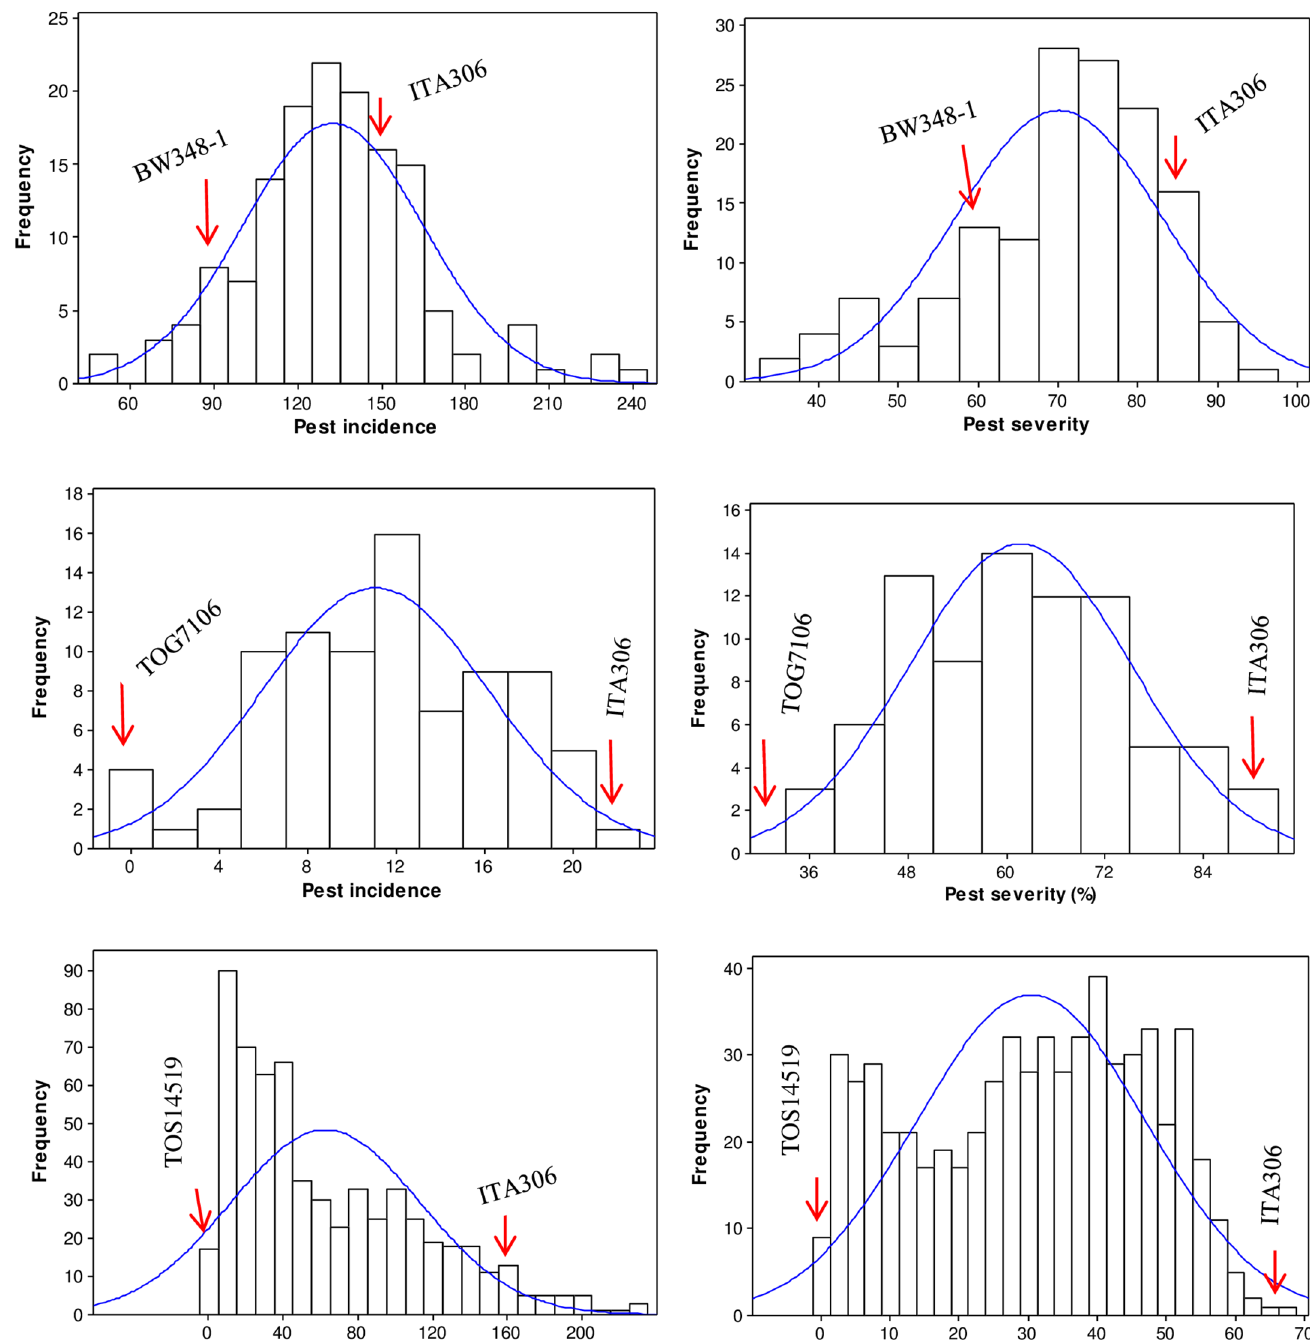
Fig 2. Frequency distribution of pest incidence (number of plants infested with galls) and pest severity (percentage of plants infested with galls) in the ITA306xBW348-1 (top), ITA306xTOG7106 (middle), and ITA306xTOS14519 (bottom) populations. Arrows indicate the values of two